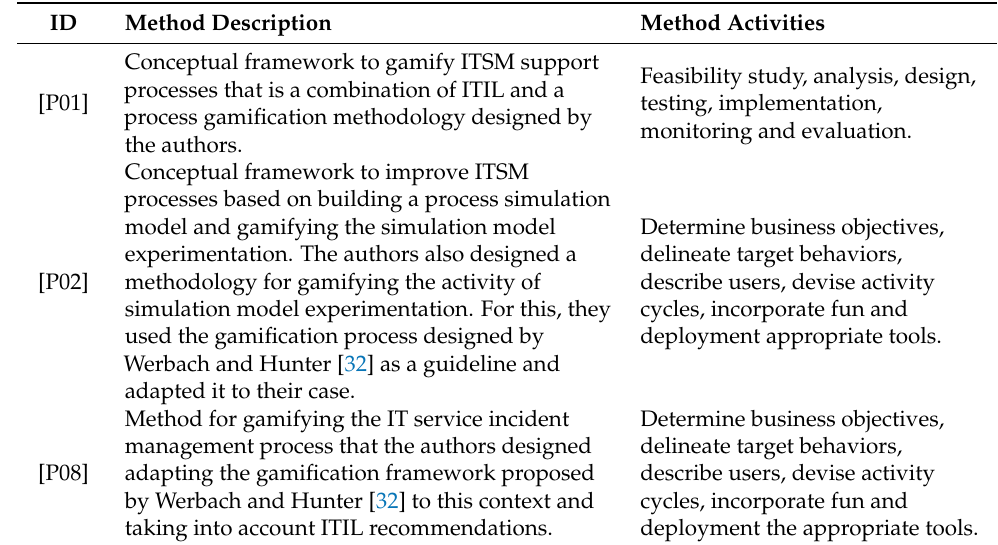
Table 12. Summary of the data collected about the gamification methods used in the primary